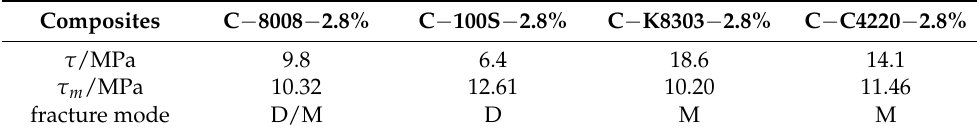
Table 4. Calculated τ and τ m for the composites and corresponding fracture mechanisms.